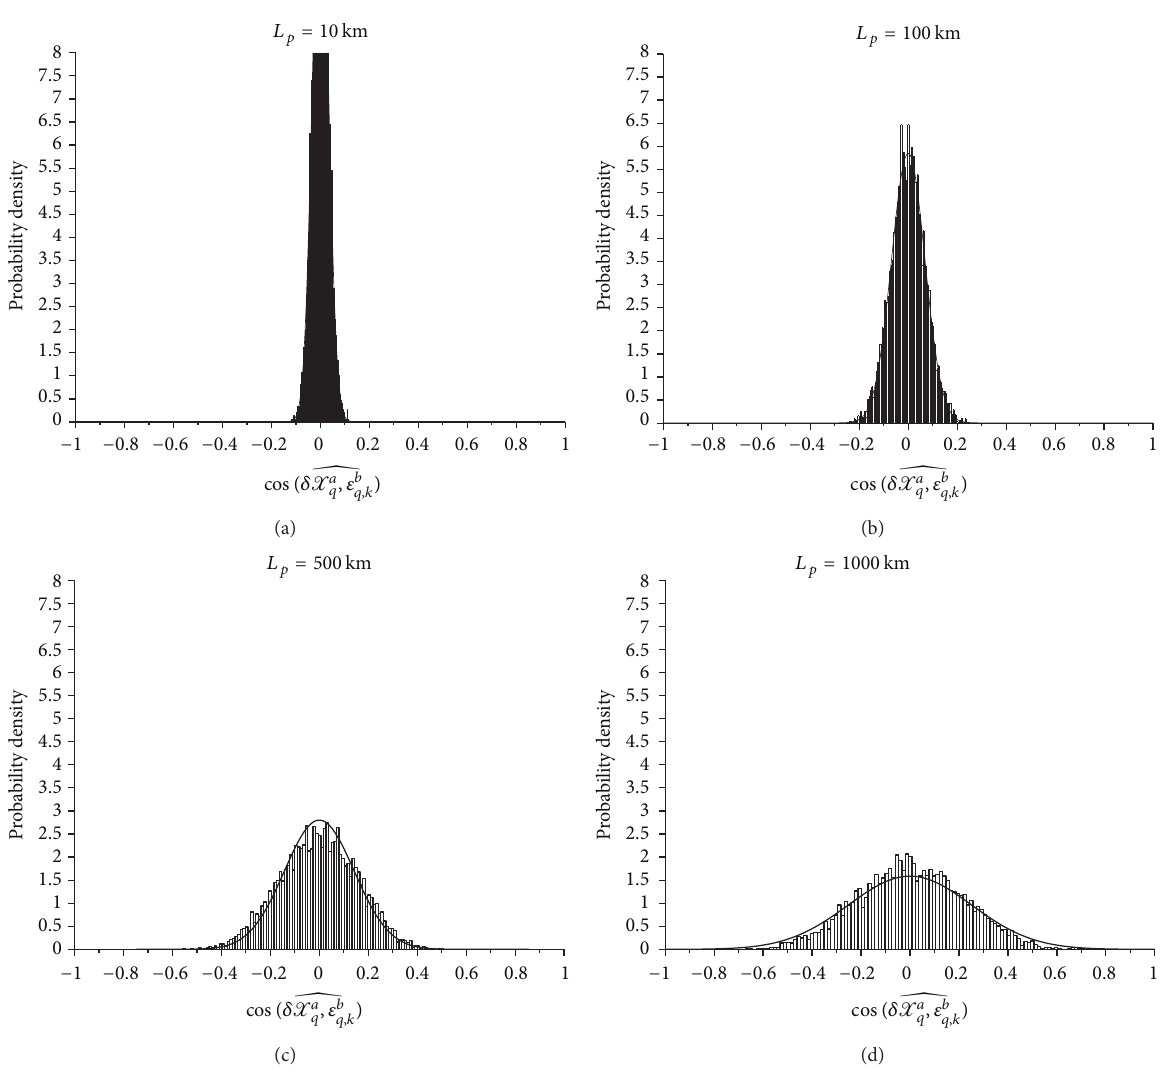
𝜀 𝑏 𝑞,𝑘 deduced